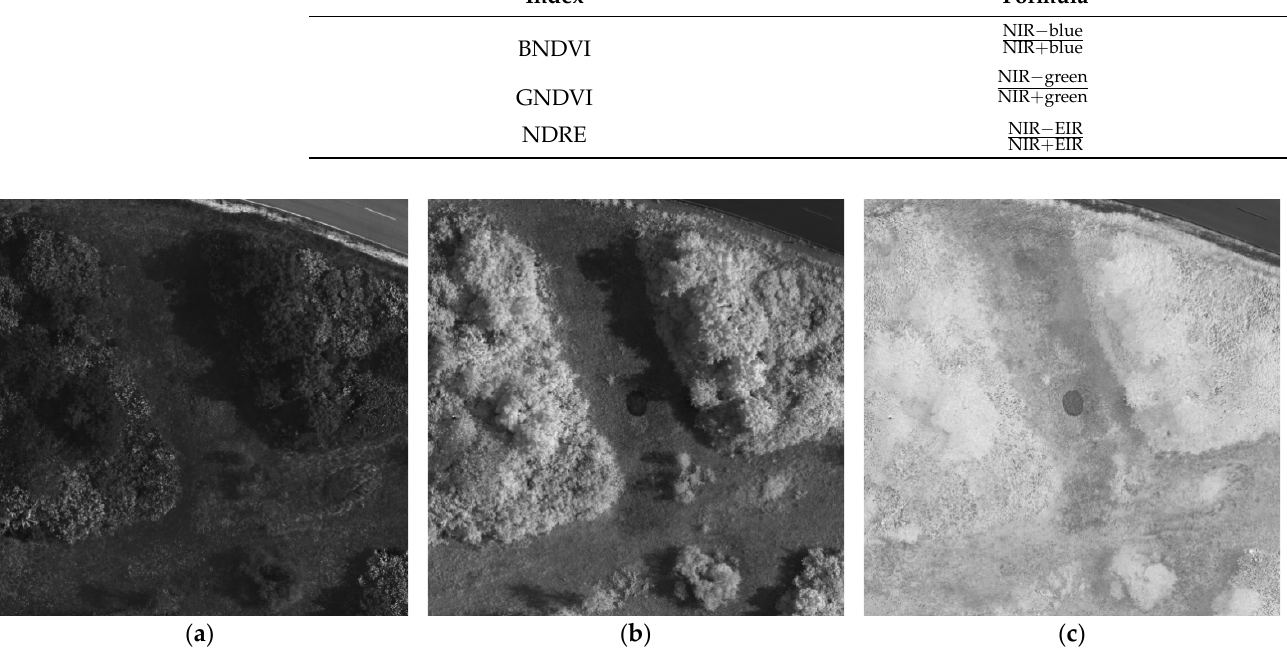
Figure 6. The vegetation index BNDVI calculated with NIR and blue bands increases visibility of 3D camouflage net in its environment compared to both raw bands. ( a ) blue; ( b ) NIR; ( c ) BNDVI. Table 2. Vegetation indices for online extension of MUCAD.